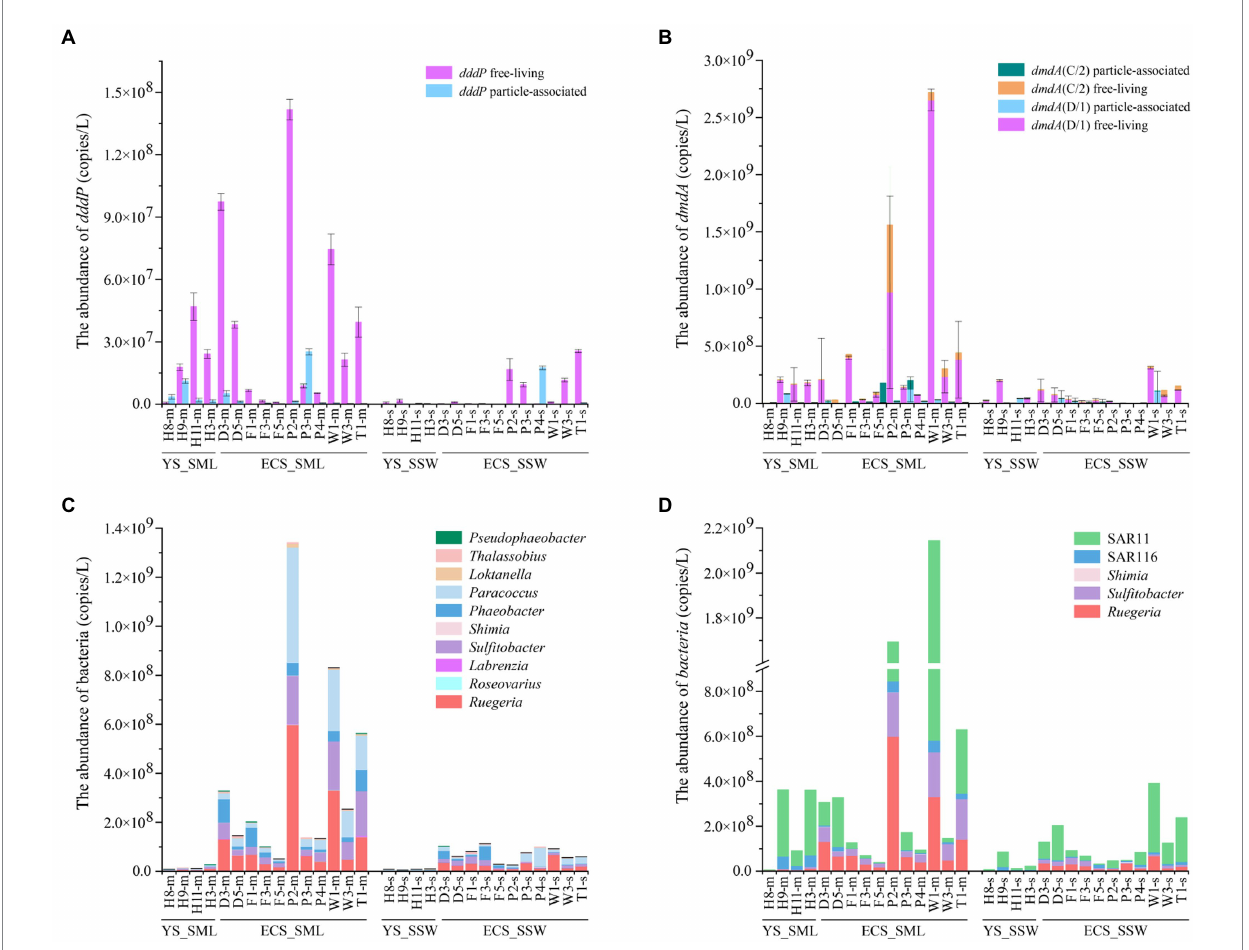
FIGURE 6 The abundance of DMSP catabolic organisms and genes in the SML and SSW samples from the East China Sea and the Yellow Sea in summer. (A) , The abundance of dddP determined by qPCR. (B) , The abundance of dmdA determined by qPCR. (C) , The abundance of genera with representatives known to contain dddP . (D) , The abundance of genera with representatives known to contain dmdA . Three technical replicates are set for each sample. The SML and SSW samples are indicated with “m” or “s” in their sample names, respectively. YS_SML, the Yellow Sea SML samples; ECS_SML, the East China Sea SML samples; YS_SSW, the Yellow Sea SSW samples; ECS_SSW, the East China Sea SSW